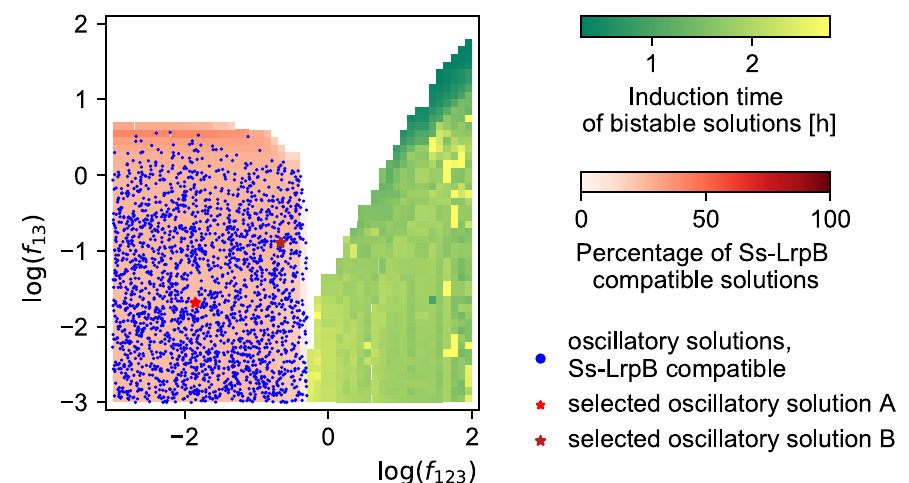
Fig 9. Bistable region with induction times in the f 123 - f 13 -plane. The bistable region is shown in yellow and green where the color represents the induction time of the fastest solution found for every f 13 - f 123 -combination. In red the percentages of Ss-LrpB compatible solutions are given. The regions of bistable systems (yellow-green) and Ss-LrpB compatible solutions (red) are not overlapping, we can therefore conclude that the natural Ss-LrpB system cannot exhibit bistability.